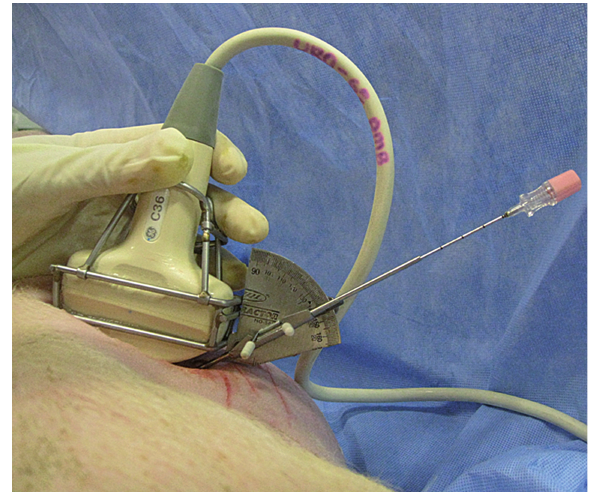
Figure 4 - Ilustration of the Punctiometer in